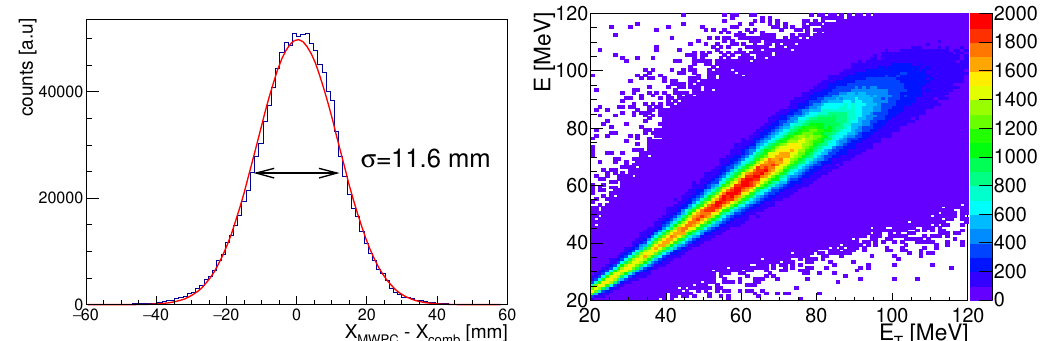
Figure 2: Check of momentum reconstruction methods on the basis of registered protons: Left panel: Histogram of the differences between the x -coordinate recon- structed from combined TDC and ADC method and the x -coordinate obtained from MWPC. Right panel: Energy reconstructed from the deposited energy in the E detec- tor versus energy obtained from the time of flight method E